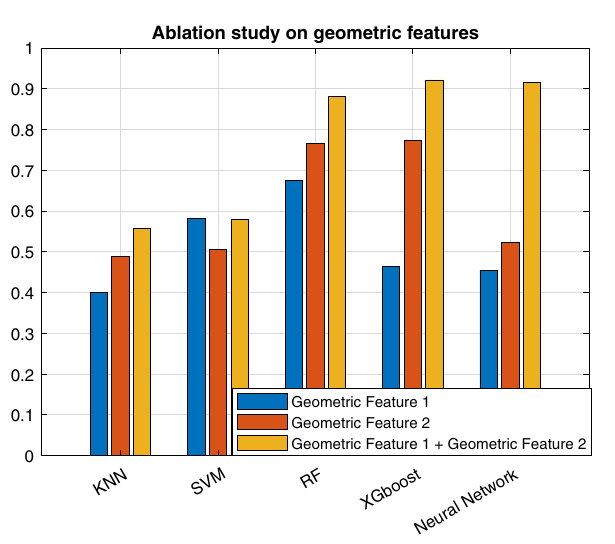
Figure 6. Ablation study on geometric